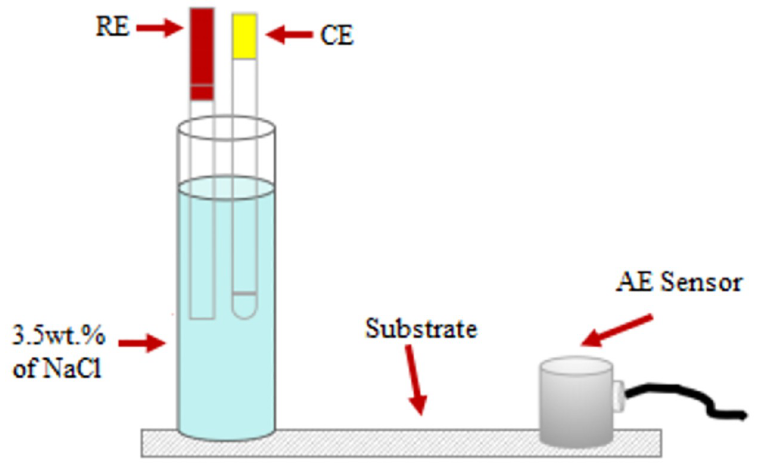
Fig 1. Corrosion test set-up, connected to AE sensor and potentiostat for acquisition.